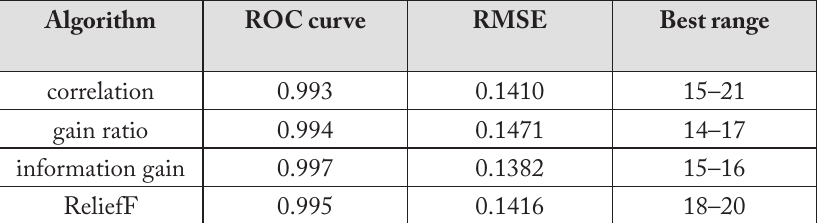
Table 6: Performance summary of feature selection algorithms